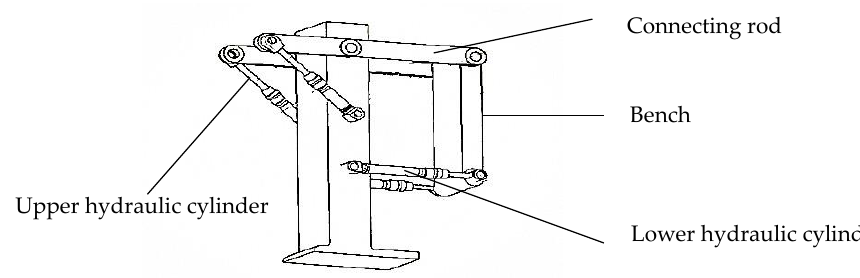
Figure 35. Tilting mechanism.